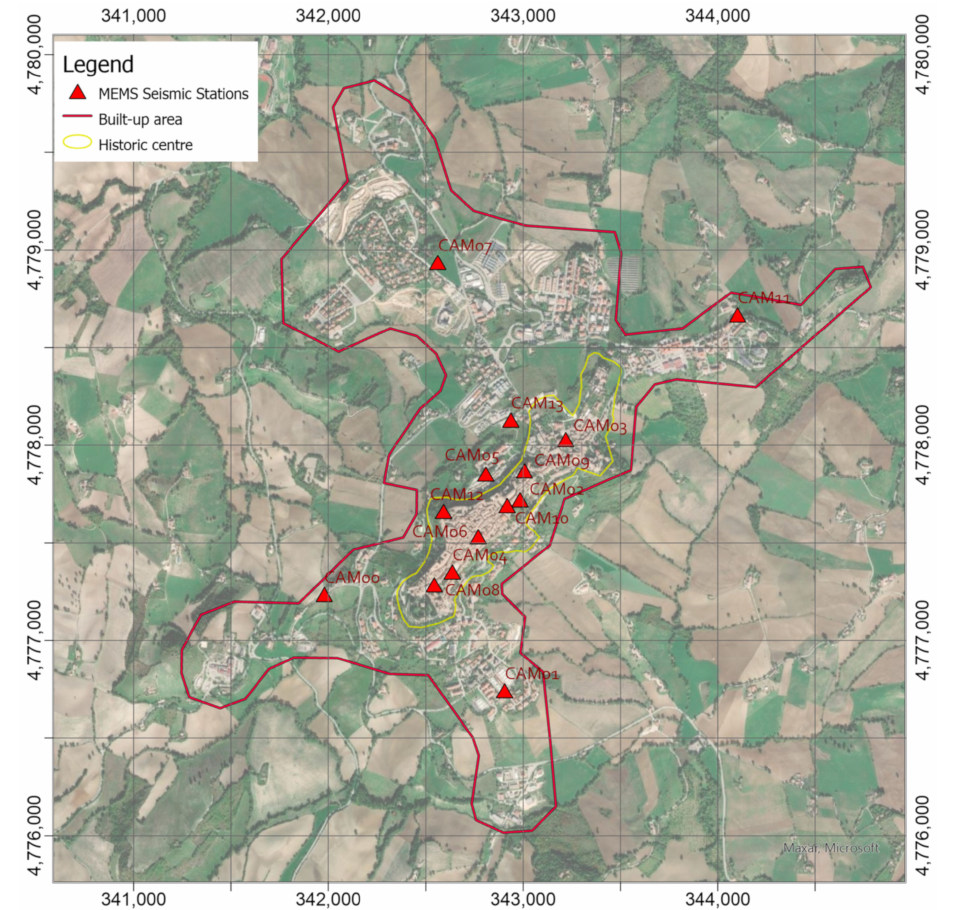
Figure 3. Urban seismic network deployed in Camerino, which is constituted by MEMS accelero- metric stations (red triangles) on and around the historic center. (Coordinate System WGS84 UTM zone